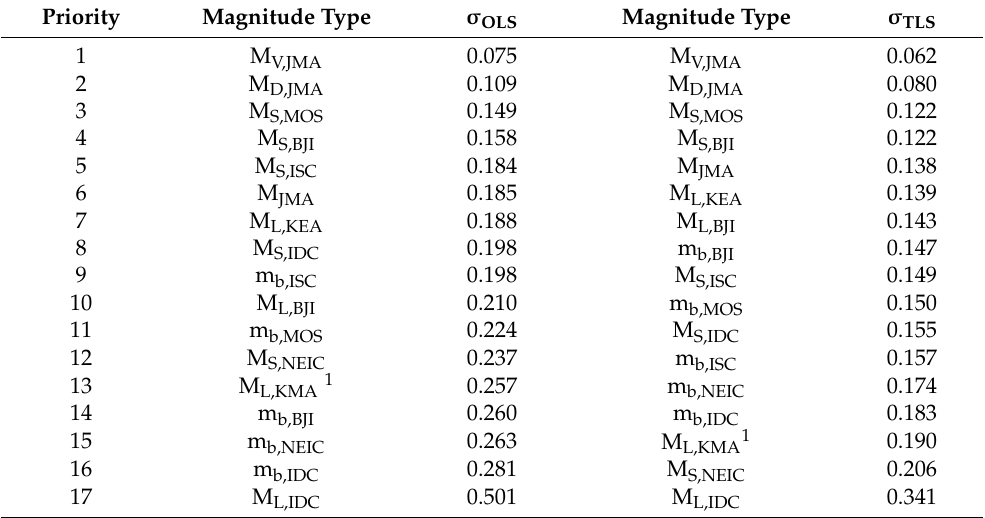
Table 4. Comparison of the different rankings of magnitude type regressions based on σ OLS and σ TLS